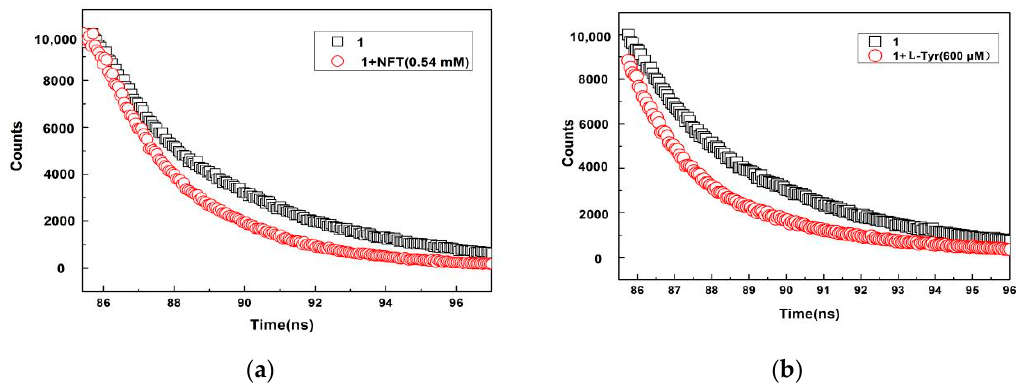
Figure 6. ( a ) The decay curve of 1 with the addition of NFT; ( b ) The decay curve of 1 with the addition of L -Tyr. Table 1. The lifetimes of 1 with or without the addition of NFT and L -Tyr.